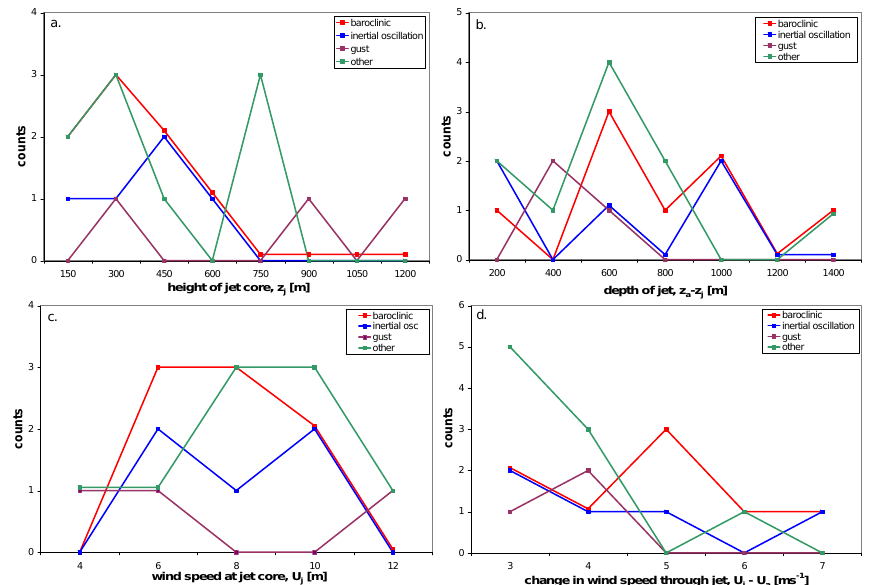
Fig. 6. Summary of the LLJ properties (indicated as counts): (a) the height of the jet core ( z j ), (b) the depth of the jet ( z a – z j ), (c) the wind speed at the jet core ( U j ), and (d) the change in wind speed through the jet ( U j – U a ).